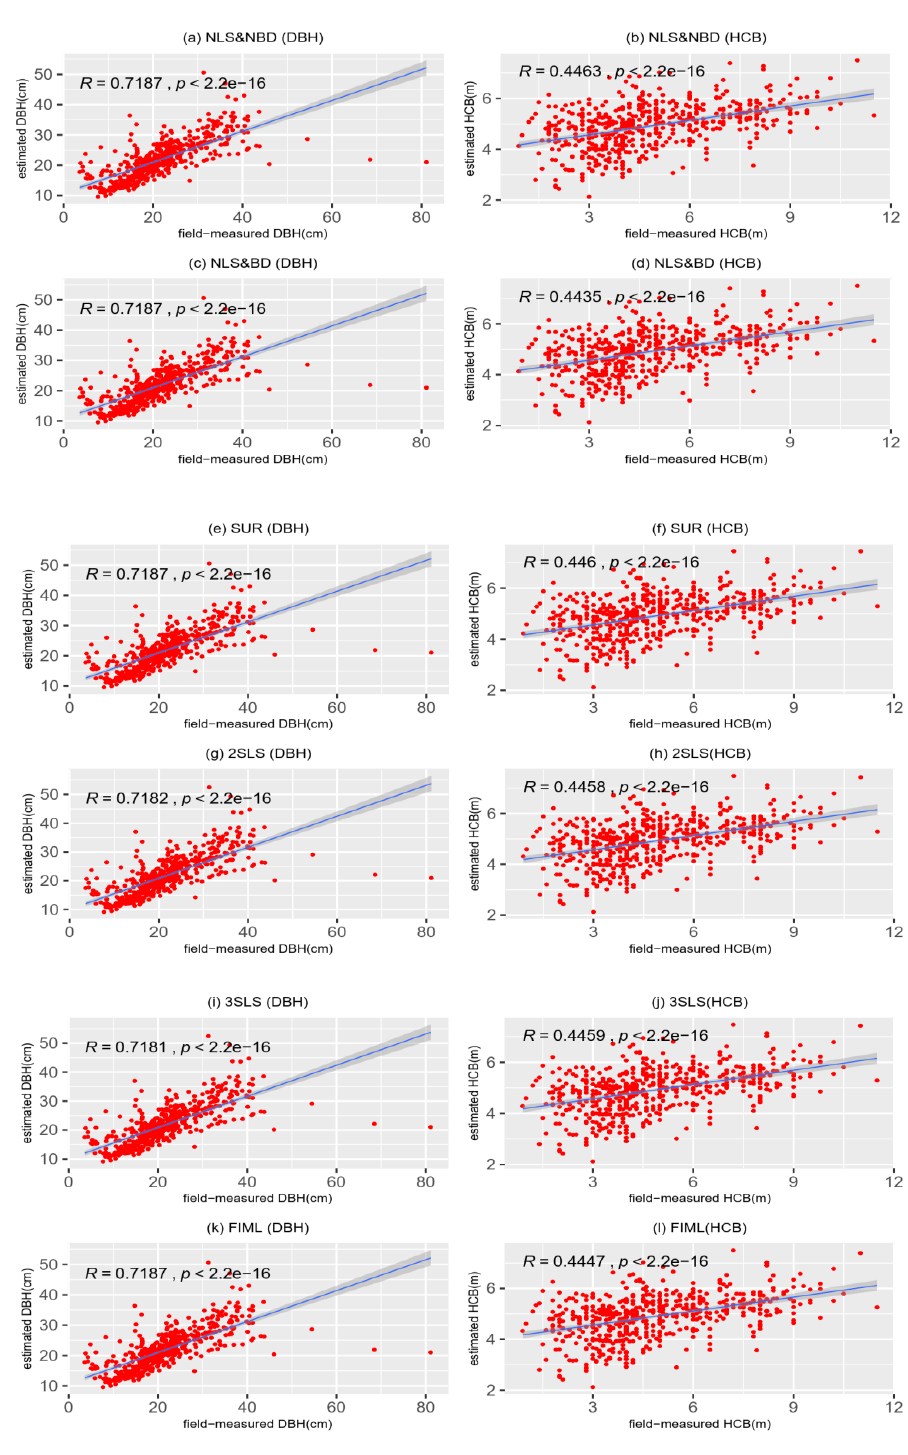
Figure 8. Correlations between the ground-measured tree diameter at breast height (DBH) and estimated DBH for nonlinear least squares with height to crown base (HCB) estimation not based on DBH (NLS and NBD) ( a ), nonlinear least squares with HCB estimation based on the DBH (NLS and BD) ( c ), NSUR ( e ), 2SLS regression ( g ), 3SLS regression ( i ), and FIML ( k ), as well as correlations between ground-measured tree HCB and estimated HCB from NLS and NBD ( b ), NLS and BD ( d ), NSUR ( f ), 2SLS ( h ), 3SLS ( j ), and FIML ( l ). R = Pearson’s correlation coe ffi